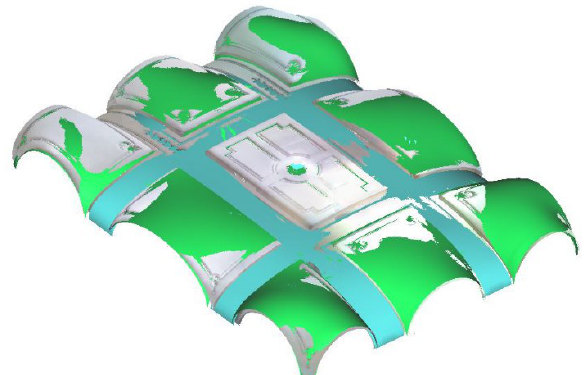
Figure 15. Superimposition of point cloud and ideal design model. Processing: F. Natta